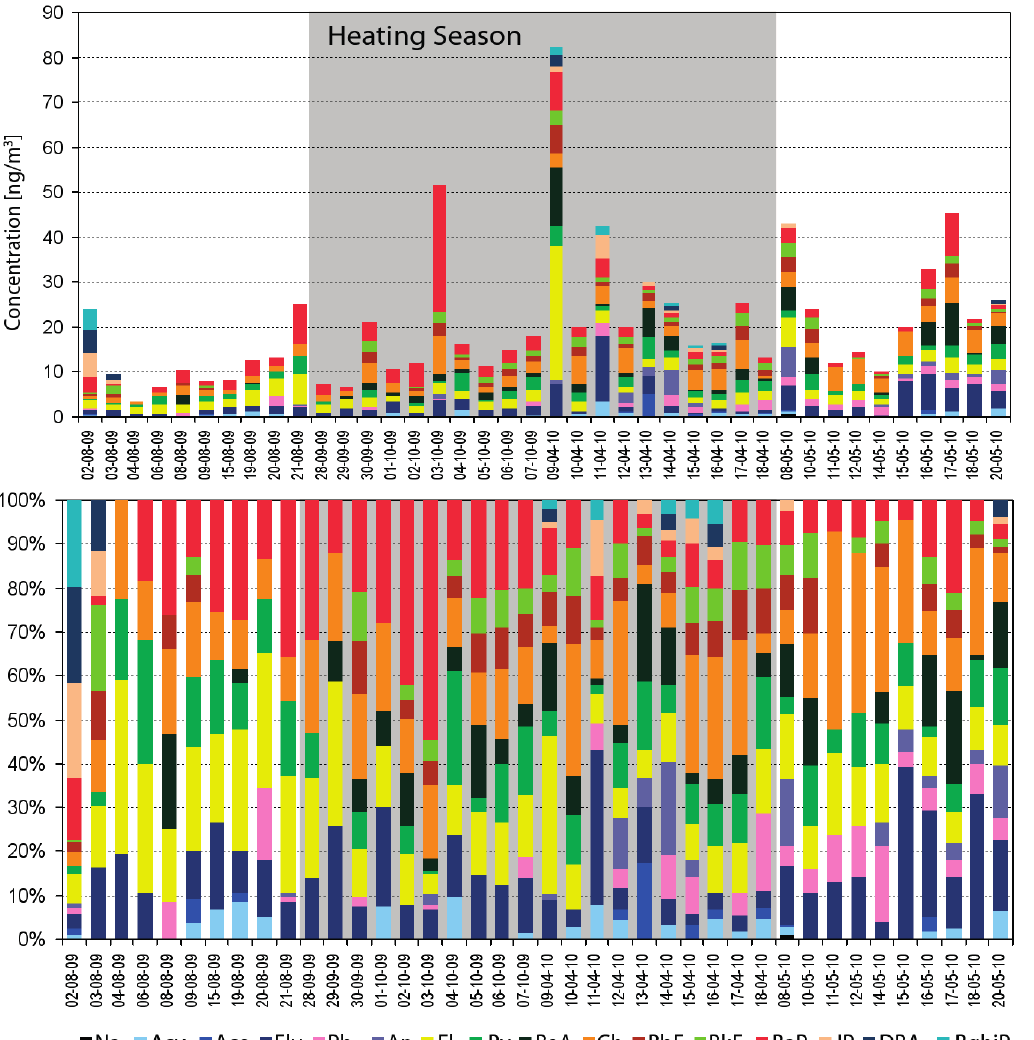
Figure 2. Twenty-four-hour concentrations of 16 PAHs contained in PM 1 and percentages of specific PAHs in the PAH sum at the regional background point